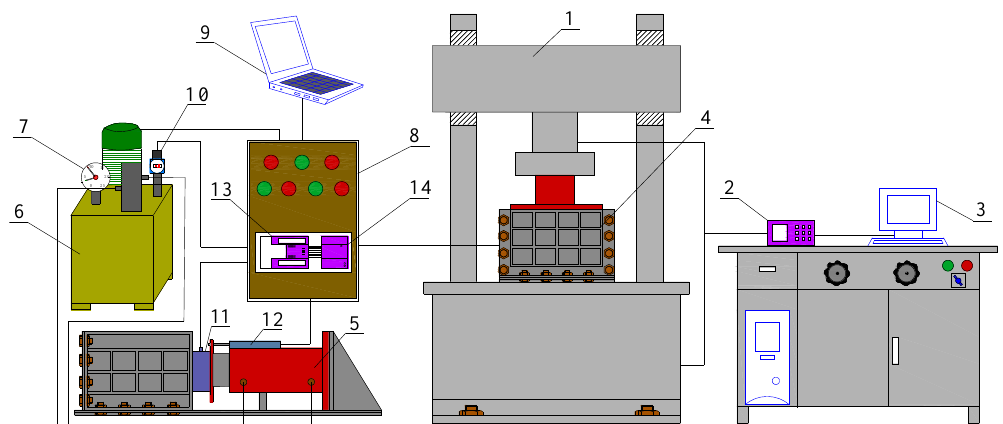
Figure 4. Schematic diagram of the structure of the test system. (1): Testing machine; (2): Controller;